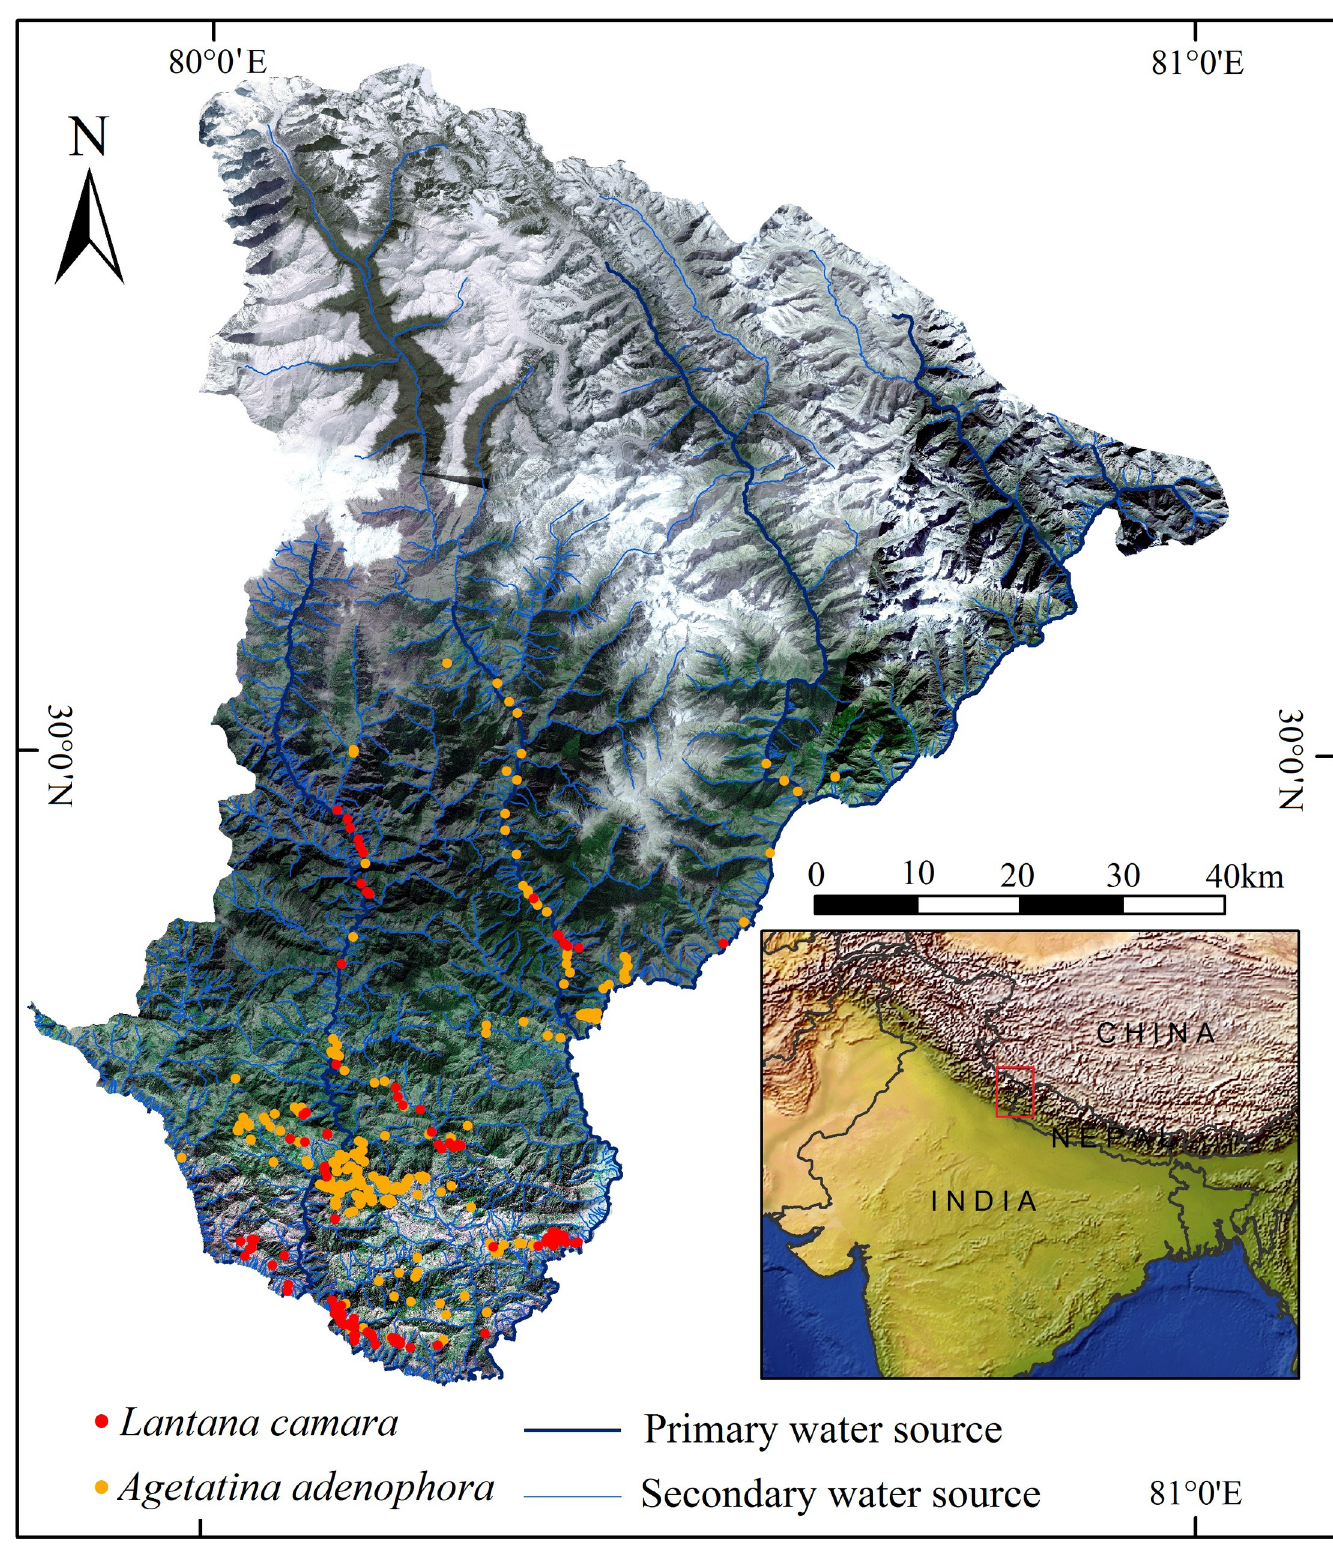
Fig 1. Geographical location of the study area with sampling locations of Lantana camara and Ageratina adenophora .